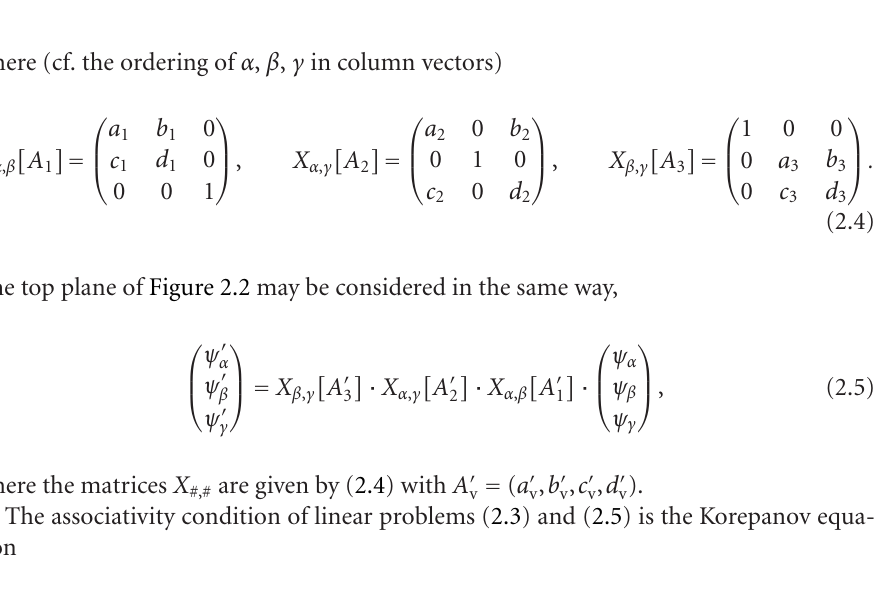
Figure 2.2. Left- and right-hand sides of Korepanov’s